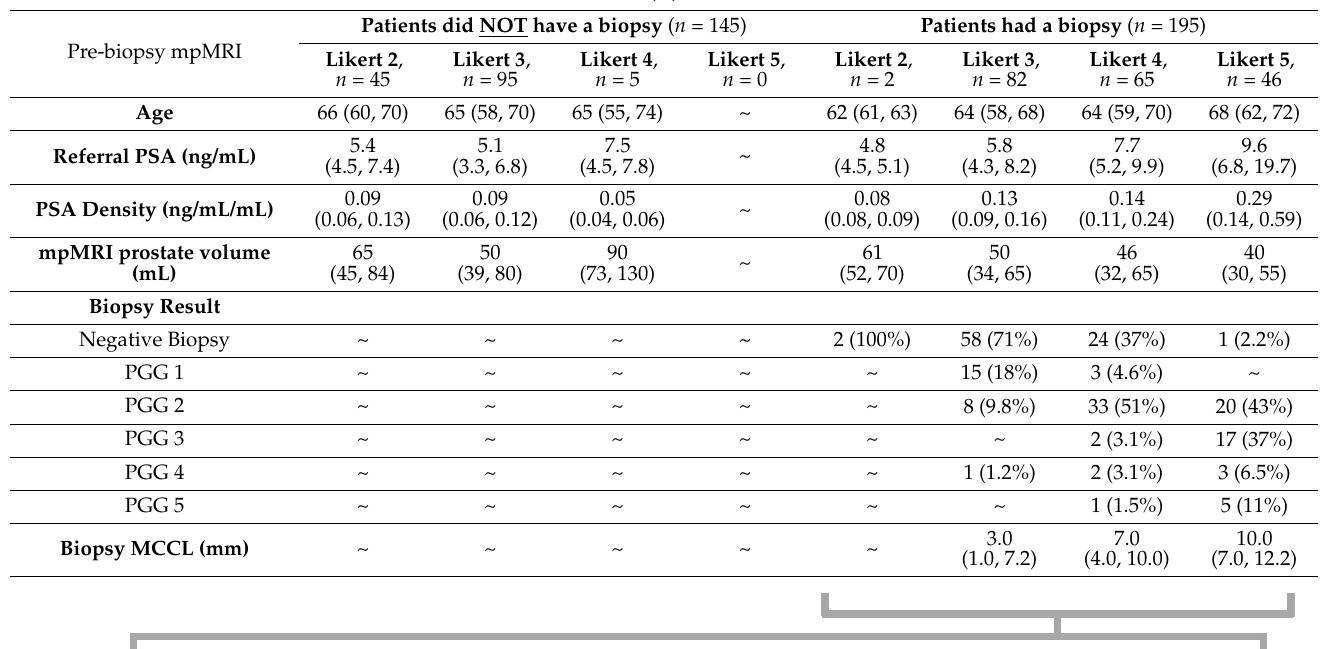
Table 1. Summary demographic, clinical, radiological and pathological outcome data for all men included in the INNOVATE trial, stratified by highest Likert score. Grouped by (Table A ) decision to biopsy and (Table B ) presence of clinically significant prostate cancer on biopsy. Biopsy result reported as prognostic grade groups (PGG). Biopsy results are reported as prognostic grade group (PGG), endorsed and accepted by the International Society of Urological Pathology (ISUP) [23].